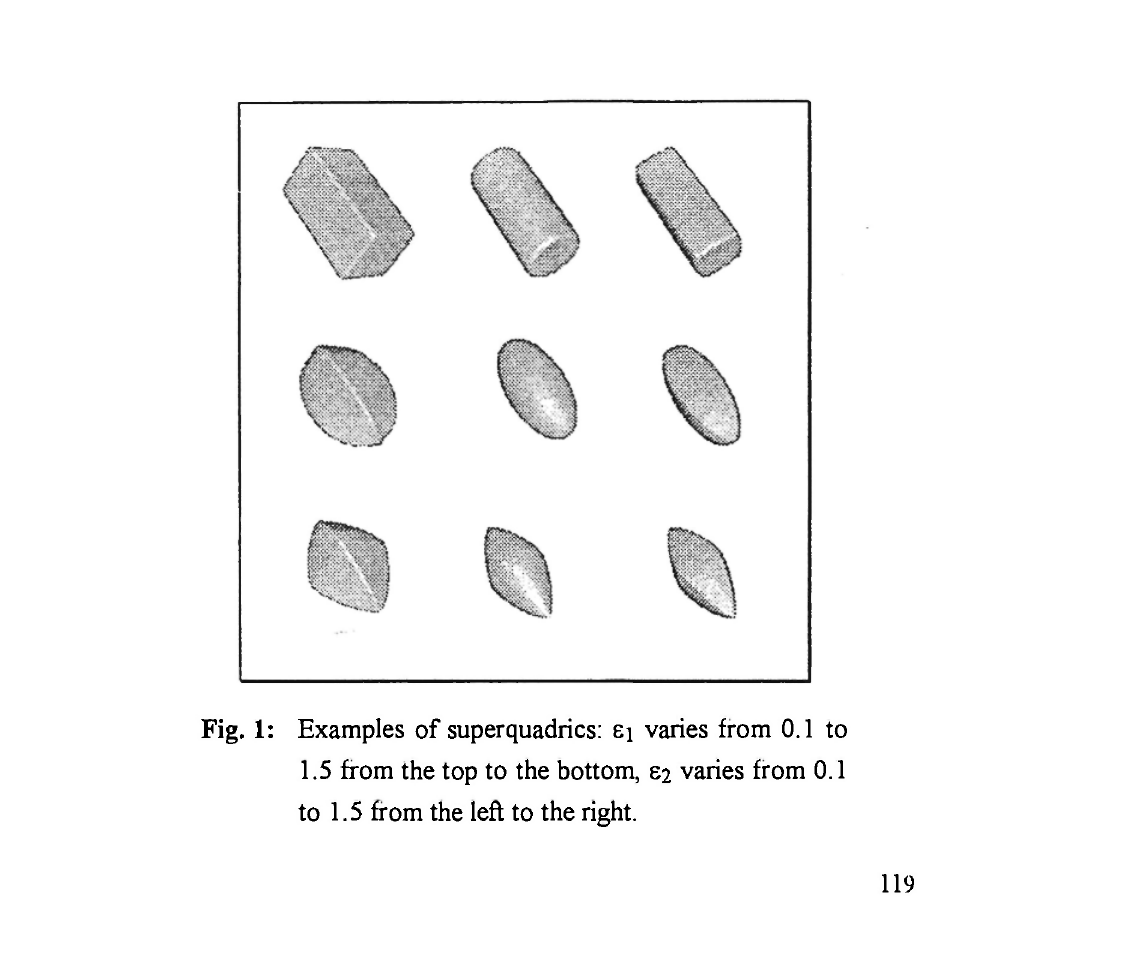
Fig. 1: Examples of superquadrics: ει varies from 0.1 to 1.5 from the top to the bottom, 82 varies from 0.1 to 1.5 from the left to the